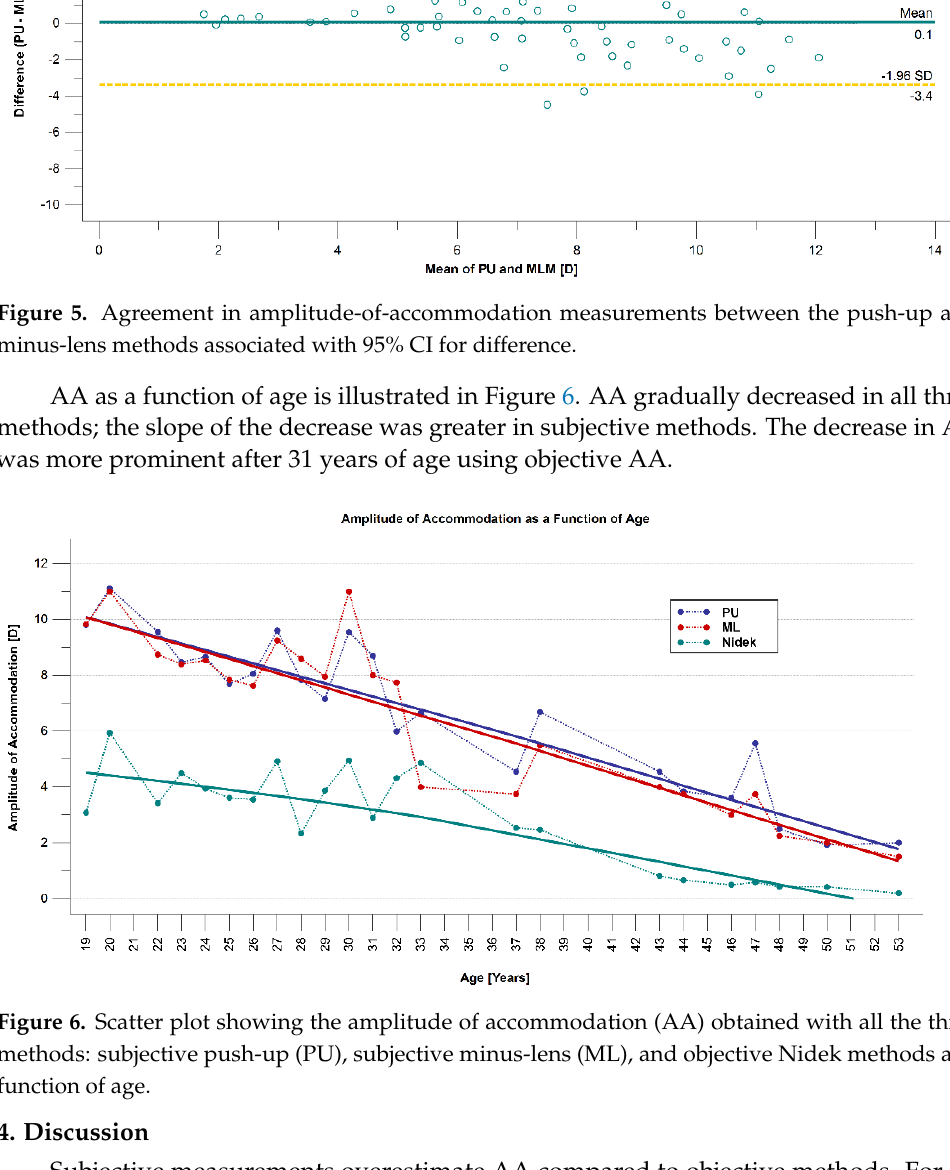
Figure 4. Agreement in amplitude-of-accommodation measurements between the Nidek autorefractor and the minus-lens (ML) method associated with 95% CI for difference.